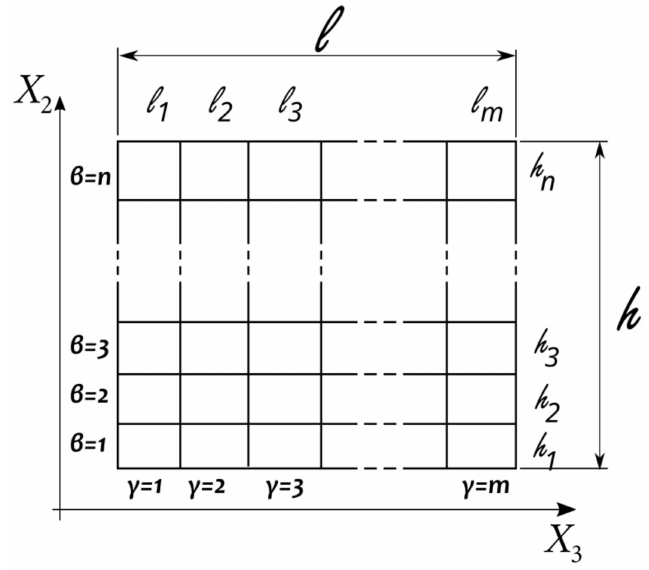
Figure 2. The geometry of a doubly periodic GMC repeating unit cell subdivided into n × m rectangular subcells. The area of each subcell is l γ × h β , where h γ and l β are the height and length, respectively, of subcell γ , β . The total area of the RUC is